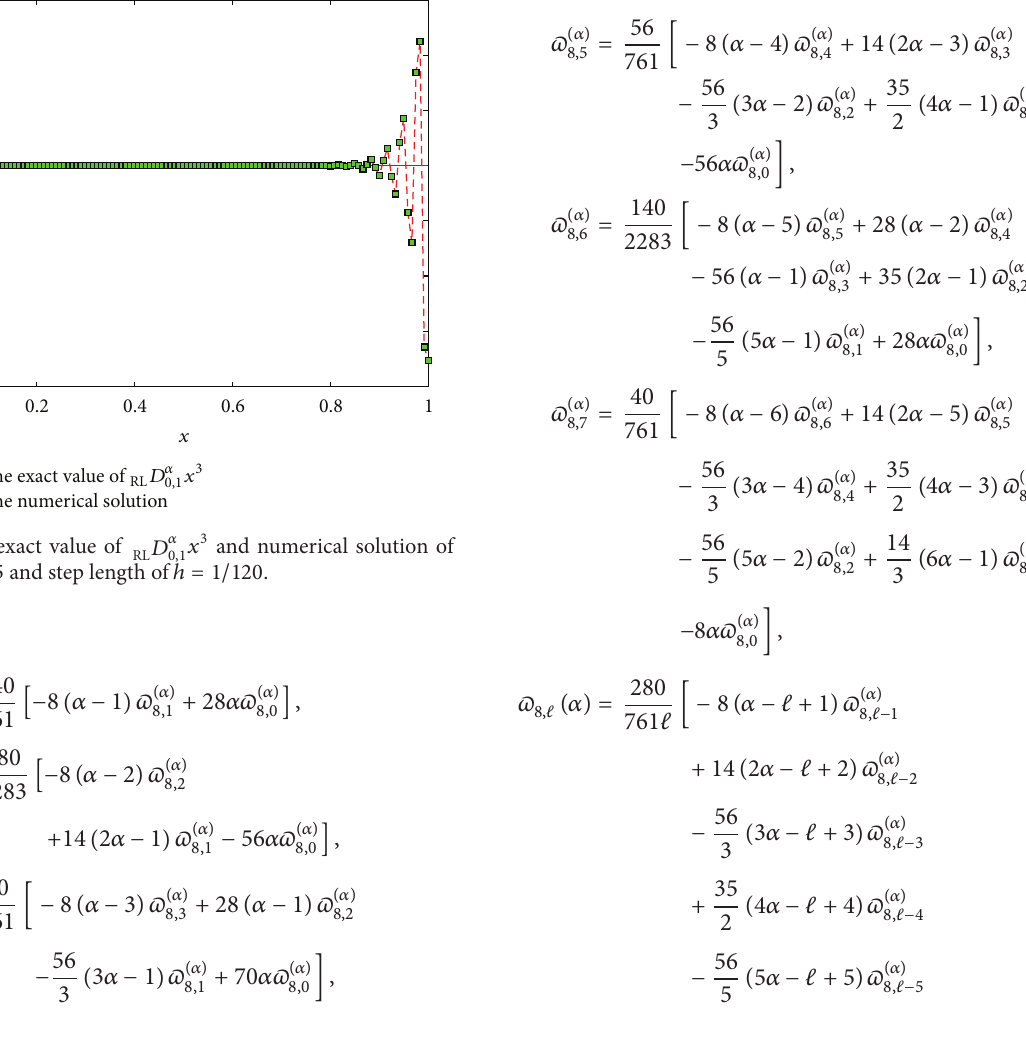
Figure 12: The exact value of 𝑝 = 10 for 𝛼 = 0.5 and step length of ℎ = 1/120